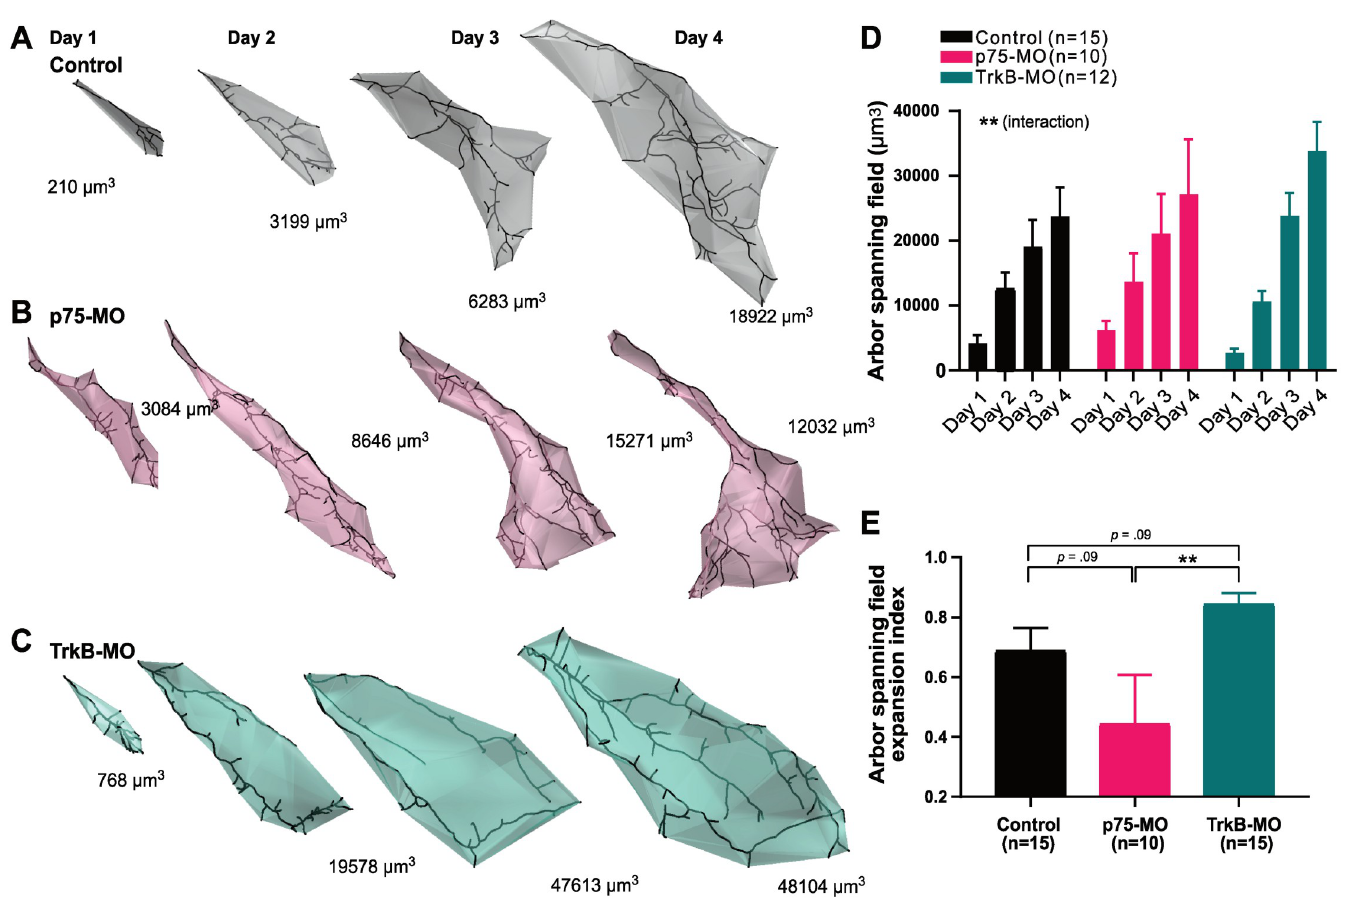
Fig 4. Arbor span compactness of contralaterally projecting RGC axons is affected by retinal TrkB-MO and p75-MO. (A–C) Three-dimensional spans of reconstructed RGC axon arbors over 4 days, co-electroporated with EGFP and MO: (A) Ctrl-MO, (B) p75-MO, and (C) TrkB-MO. (D) Significant interaction in the two- way mixed design model: ** p = 0.00119. (E) TrkB-MO leads to a faster increase in arbor spanning field volume compared to p75-MO [Arbor spanning field expansion index = (day 4—day 1)/(day 1 + day 4)], analyzed by Kruskal–Wallis test, p = 0.0175, and pairwise post hoc tests corrected for multiple comparisons: ** p � 0.01. Data represent mean + SEM. (D, E) Control ( n = 15), p75-MO ( n = 10), TrkB-MO ( n = 12). The data used to generate Fig 4D can be found in S5 Data and Fig 4E in S6 Data. MO, morpholino oligonucleotide; RGC, retinal ganglion cell.